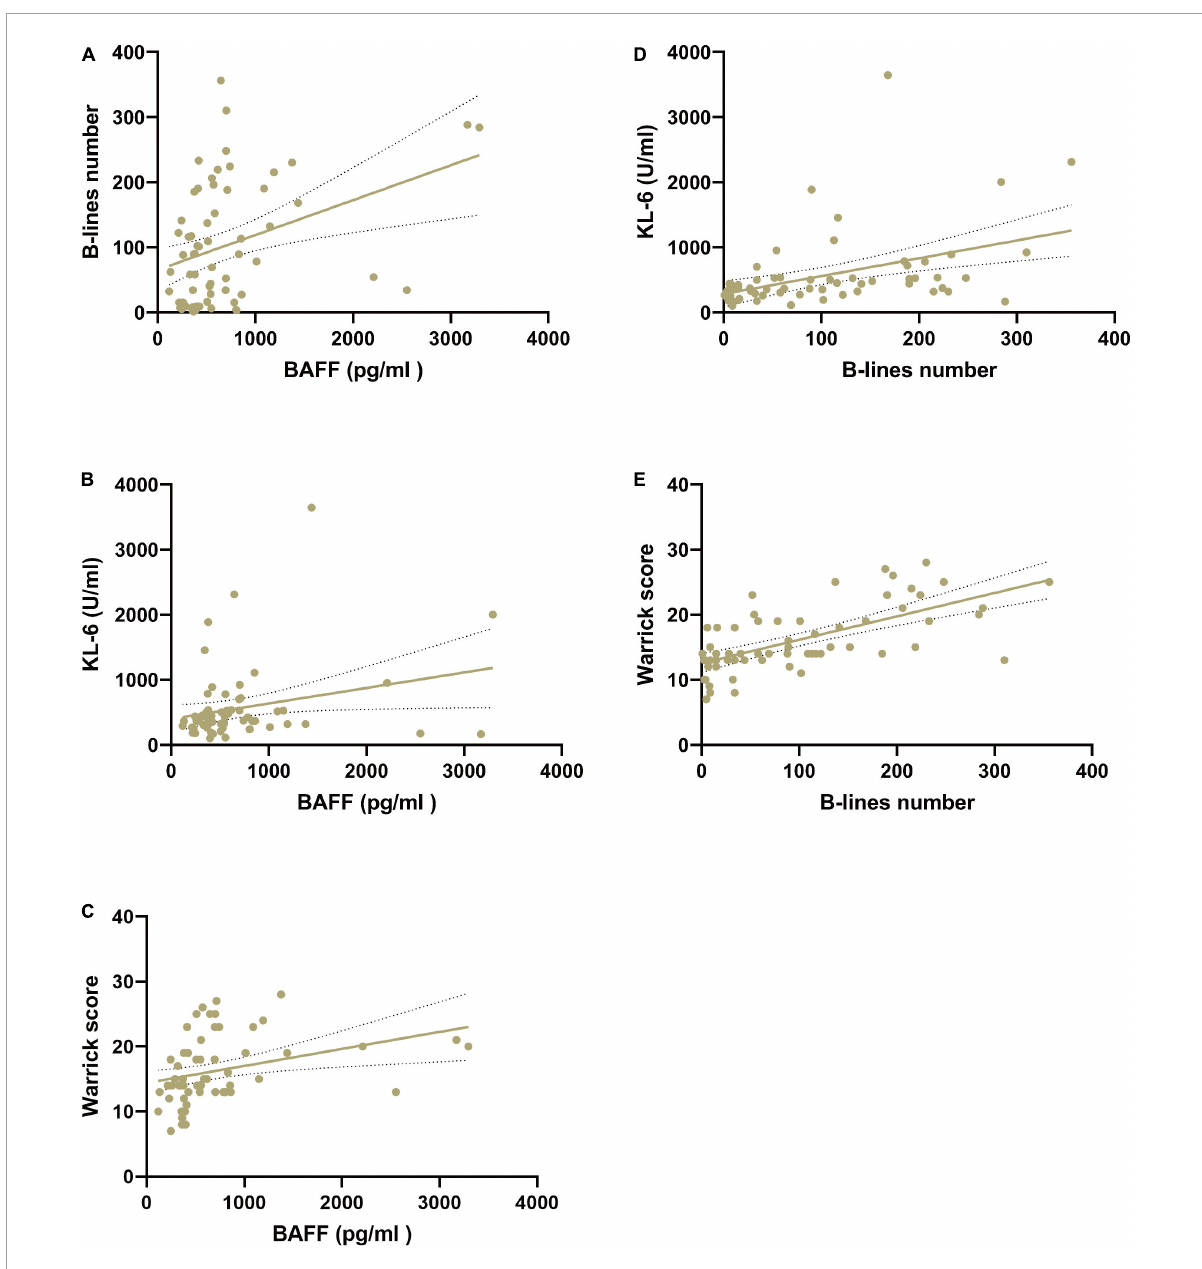
FIGURE2 Correlation among serum BAFF (pg/ml) and KL-6 (U/ml) levels, B-lines number, and HRCT Warrick score in patients with CTD-ILD. (A) Correlation of serum BAFF levels and B-lines number. (B) Correlation of serum BAFF levels and KL-6 levels. (C) Correlation of serum BAFF levels and Warrick score. (D) Correlation of serum KL-6 levels and B-lines number. (E) Correlation of B-lines number and Warrick score. BAFF, B-cell activating factor; HRCT, high resolution computed tomography; KL-6, Krebs von den Lungen-6